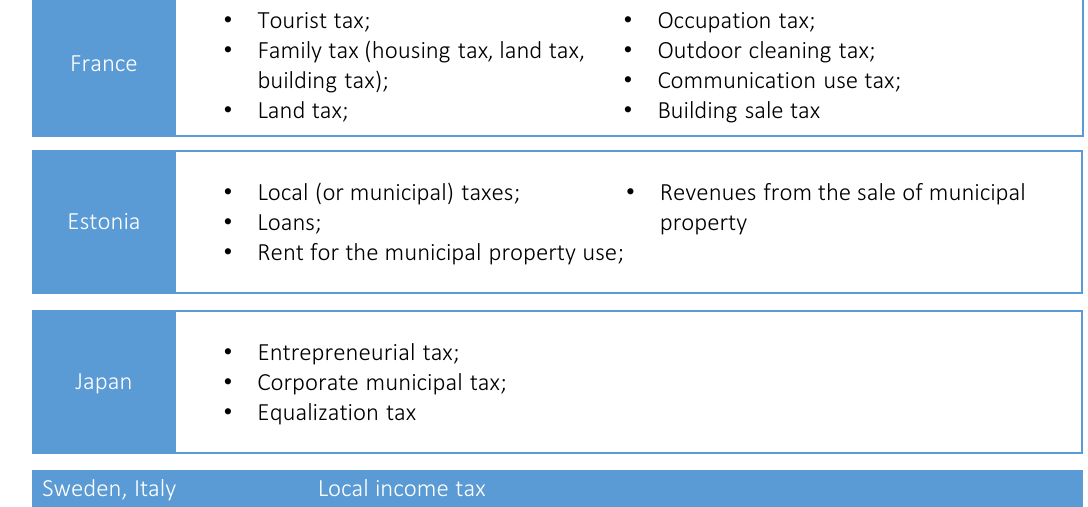
Figure 2. List of taxes belonging to local